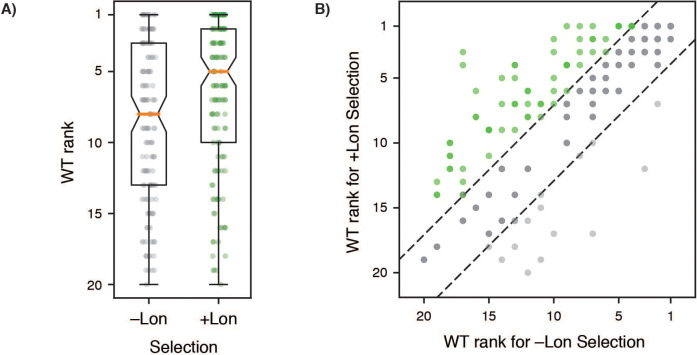
Ranks of the wild-type amino acid residues in ±Lon selections.(A) Boxplot showing the distribution of wild-type amino acid residue rankings for –Lon (grey) and +Lon (green) selection. The wild-type amino acid residue ranking at each position is also shown as a distribution of points. Box plots show the median (orange bar) and upper/lower quartiles. The median wild-type amino acid residue rank is eight for –Lon selection and five for +Lon selection. (B) Wild-type amino acid residue rankings from –Lon selection plotted against wild-type amino acid residue rankings from +Lon selection. Dashed lines show ±1 standard deviation for the change in rank between –Lon and +Lon selection.